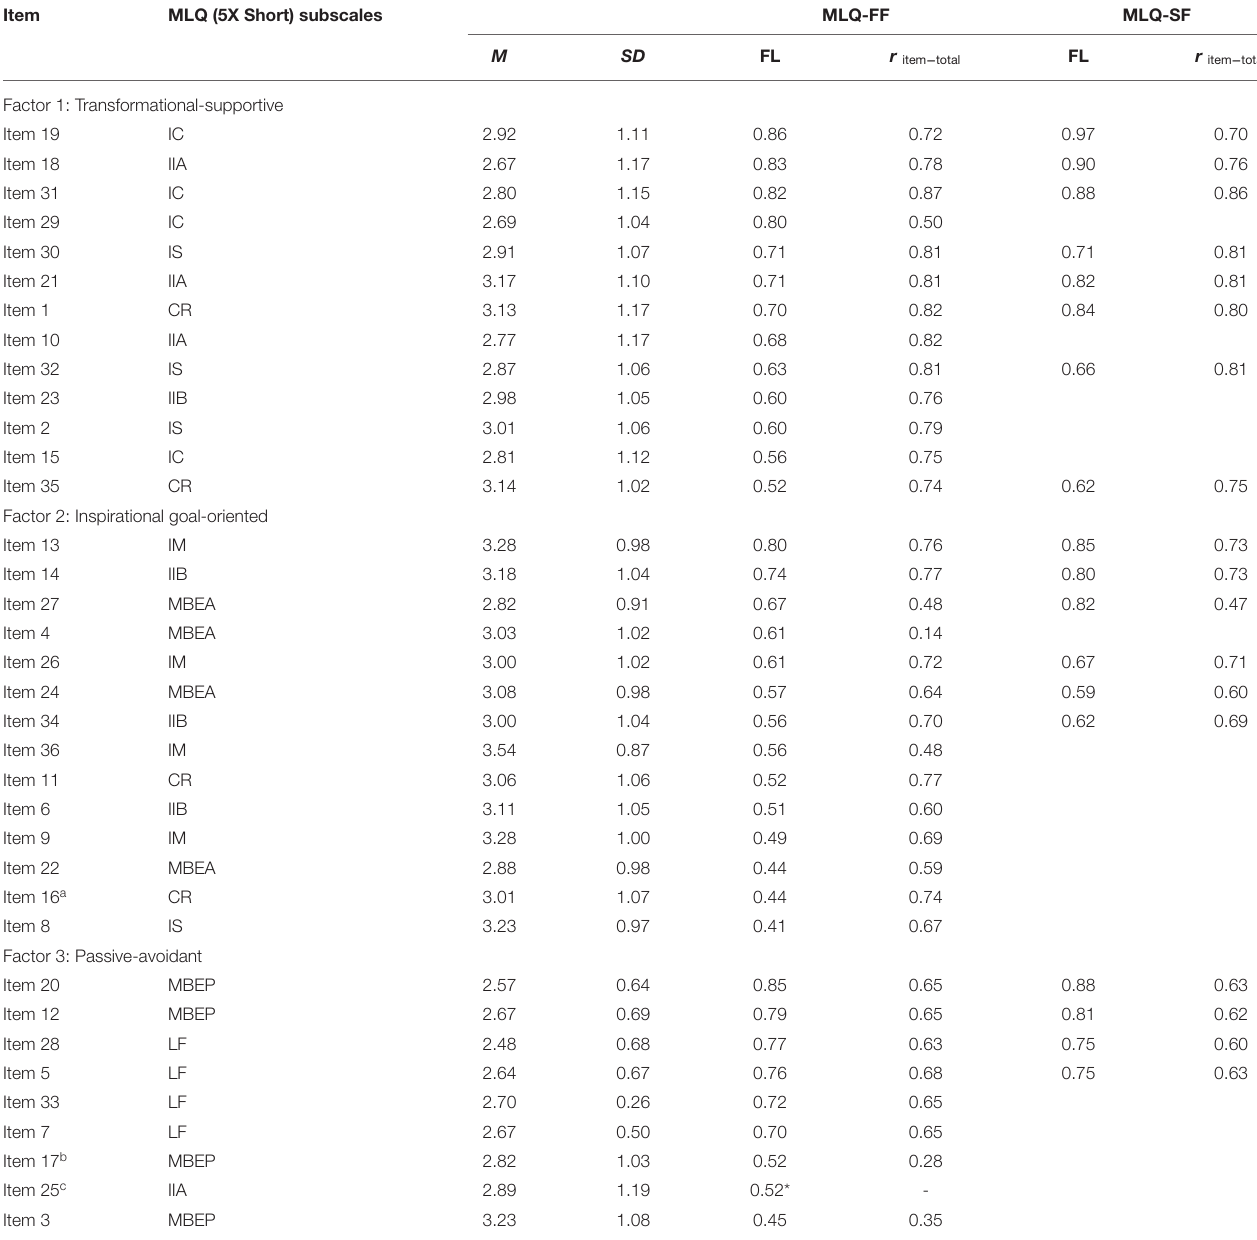
TABLE 3 | Means, standard deviations, factor loadings, and item-total correlations for MLQ-FF and MLQ-SF in subsample 1.